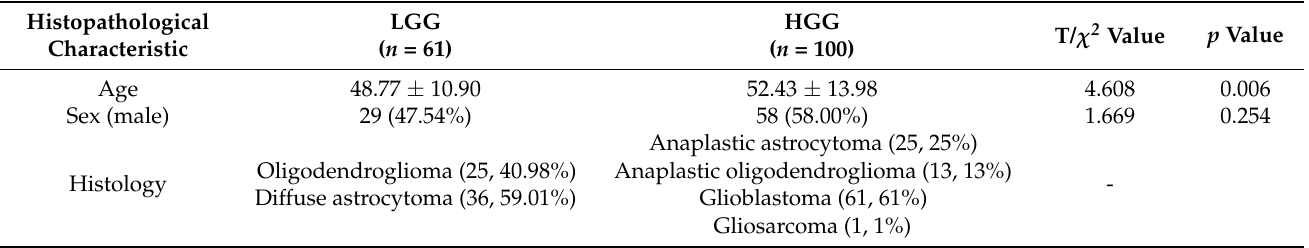
Table 2. Table 1. The clinical data and distribution of histopathological between low-grade glioma (LGG) and high-grade glioma (HGG).